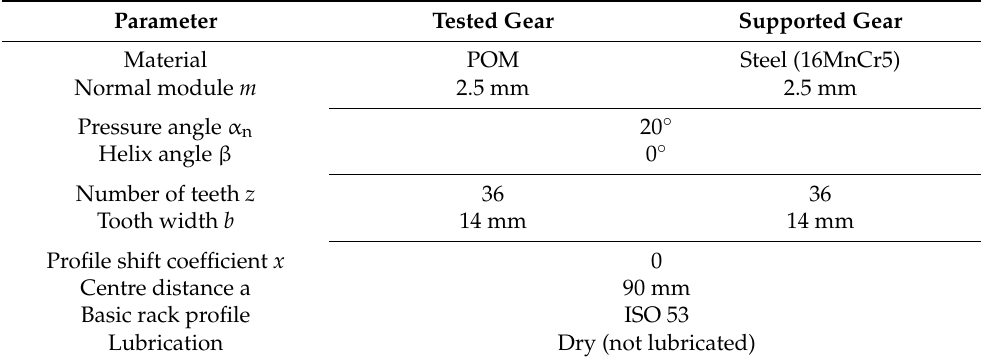
Table 3. Basic parameters of the tested gear pair.